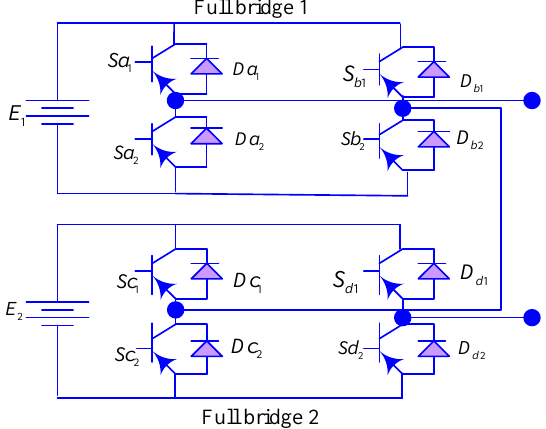
Figure 7. Topology of a 5-level CHB-MLI.